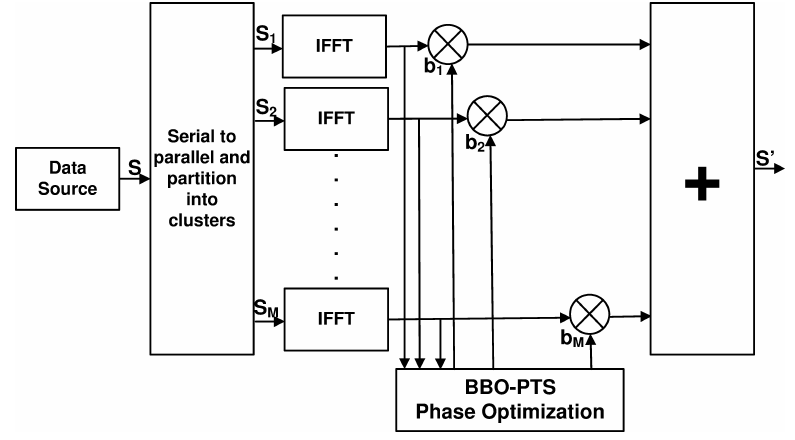
Fig. 2. Block diagram of the BBO-PTS